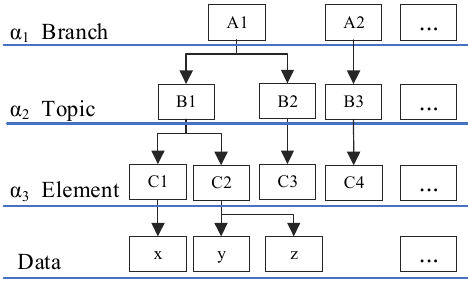
Figure 1. Data category hierarchy tree.